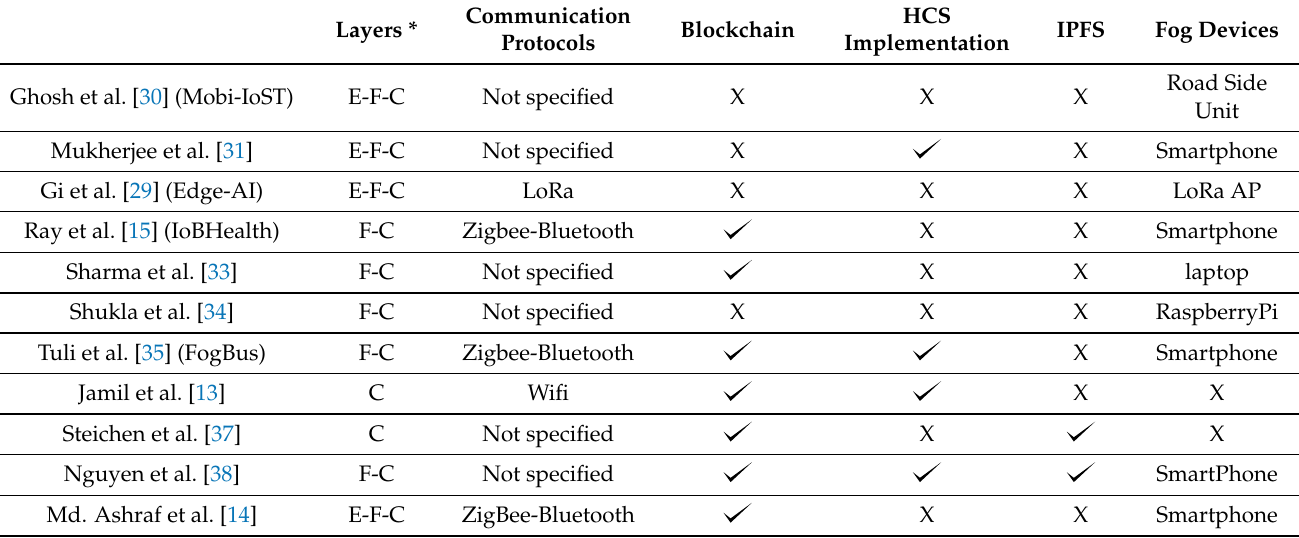
Table 1. Comparative analysis of related